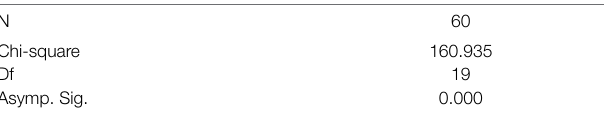
TABLE 3 | Friedman test statistics of the emotional scaffolding strategies in teachers’ views.